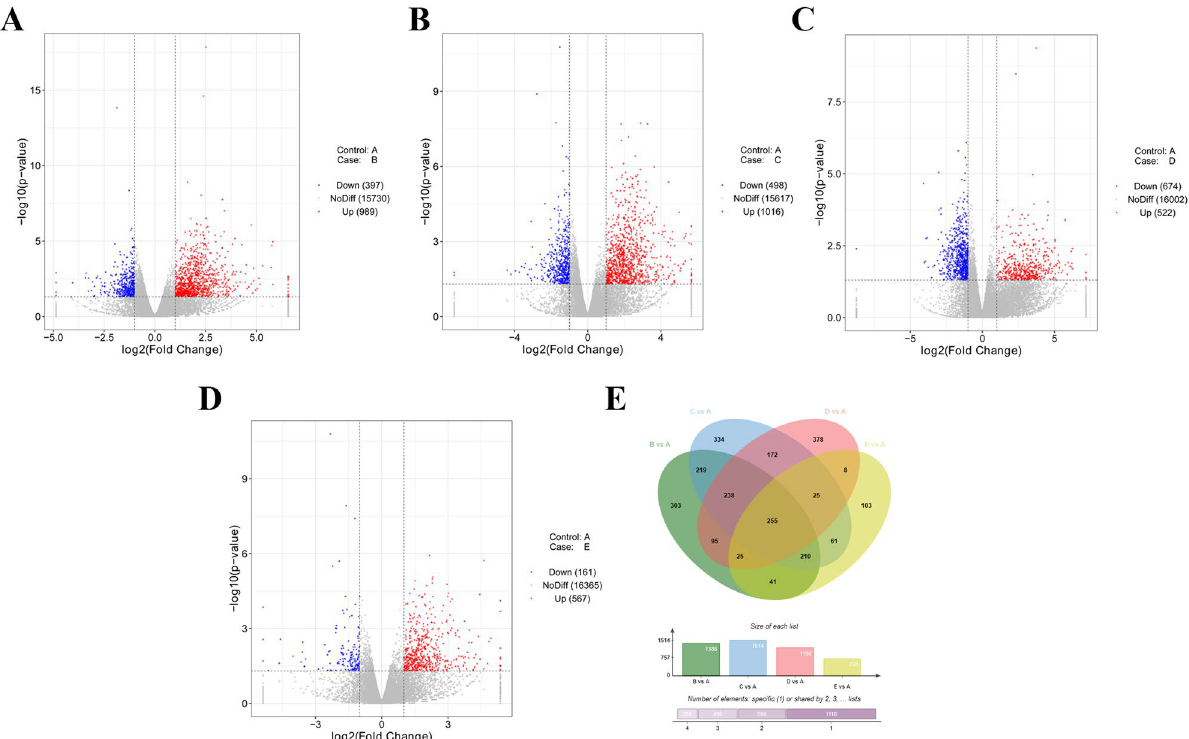
Figure 3. Identification of DE mRNAs. ( A – D ) Volcano plot of miRNA expression in B vs A ( A ), C vs A ( B ), D vs A ( C ), and E vs A ( D ) groups. ( E ) Venn diagram of DE mRNAs in B vs A, C vs A, D vs A, and E vs A groups. Venn plot was drawn by jvenn website (http:// jvenn. toulo use. inra. fr/ app/ examp le. html) 51